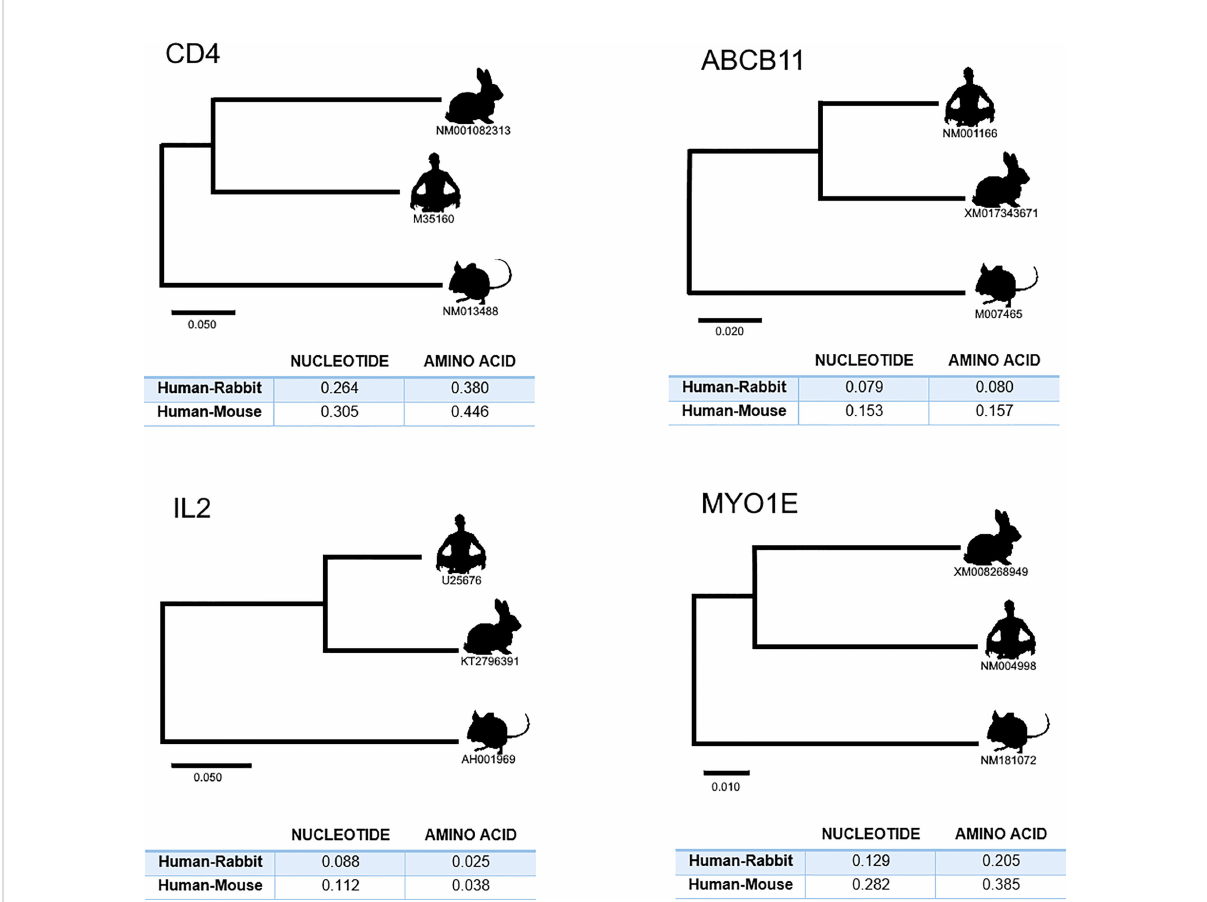
FIGURE 5 Phylogenetic relationships and genetic distances (nucleotide and amino acid) between human, rabbit and mouse for four key innate immune system genes: CD4, ABCB11, IL2 and MYO1E. Maximum likelihood (ML) method and the GTR model of nucleotide substitution were used to obtain each gene phylogenetic tree. Accession numbers of the used sequences are shown under the species symbol in the trees. The genetic distances are shown in the tables. These were obtained using the options p-distance and pairwise